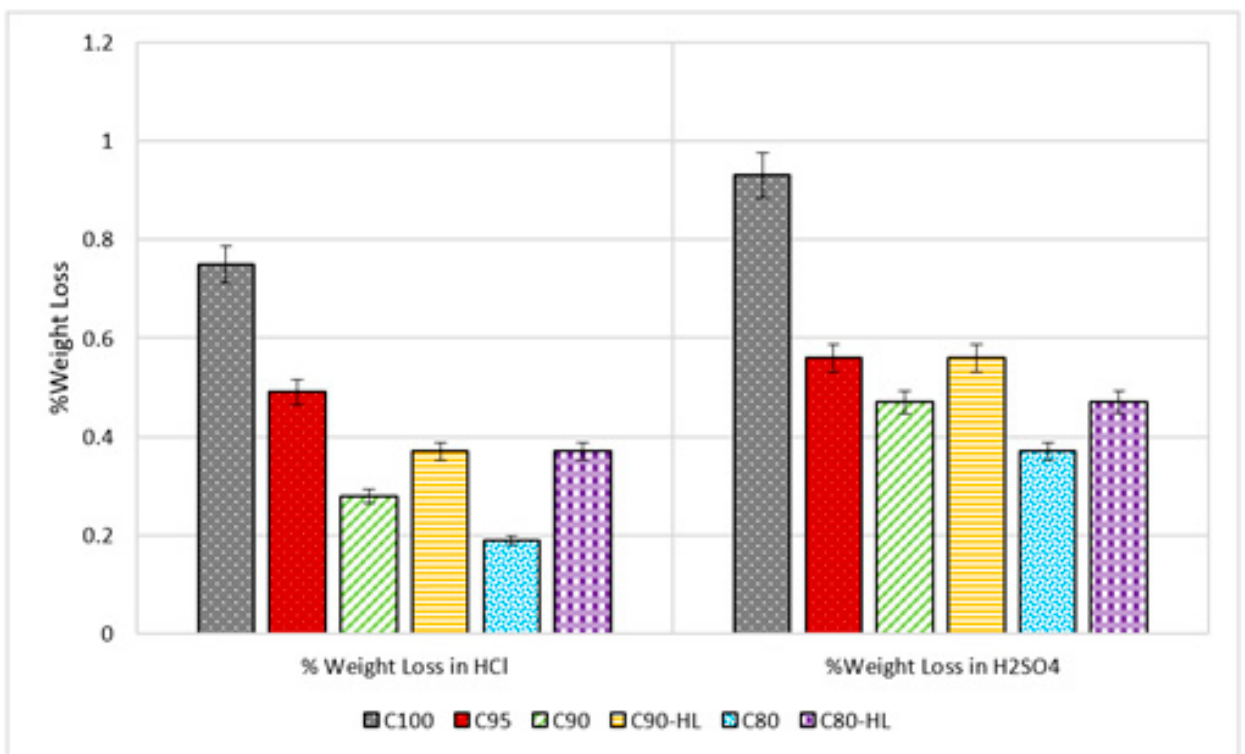
Figure 15. Percentage weight loss of samples exposed to the acidic